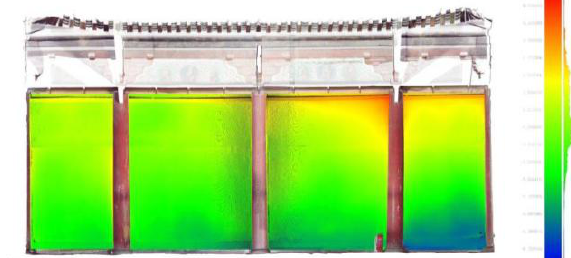
Figure 17 the Main Hall east wall shape changes for the four section mural